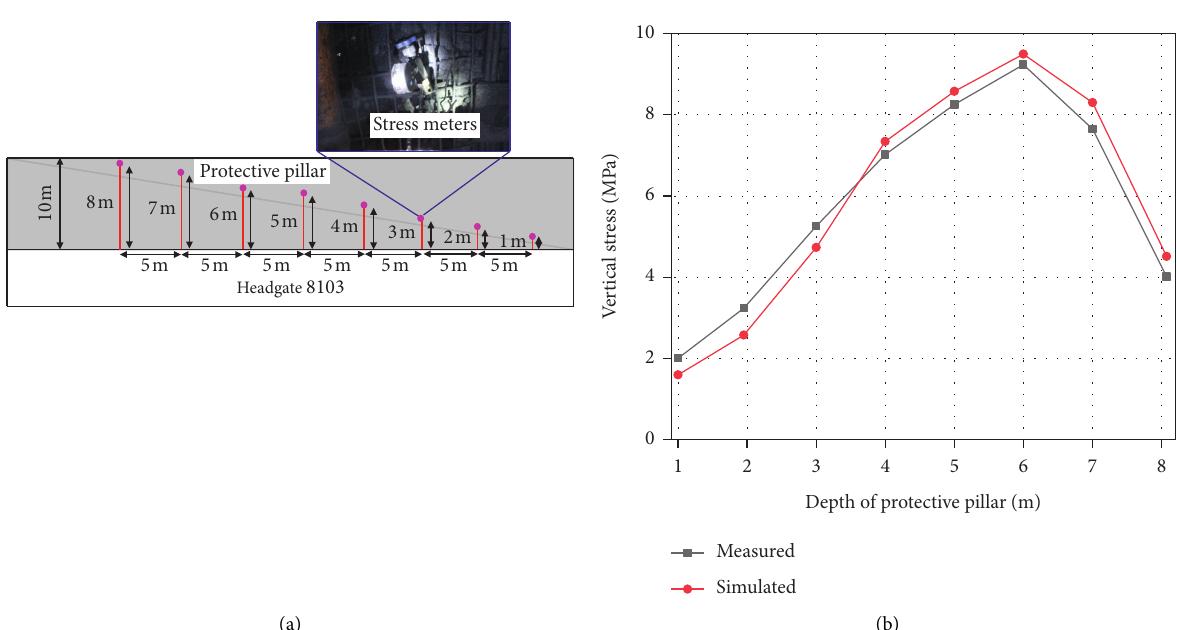
Figure 20: Stress measurement of protective pillar. (a) Layout of stress meters. (b) Distribution law of vertical stress after roadway